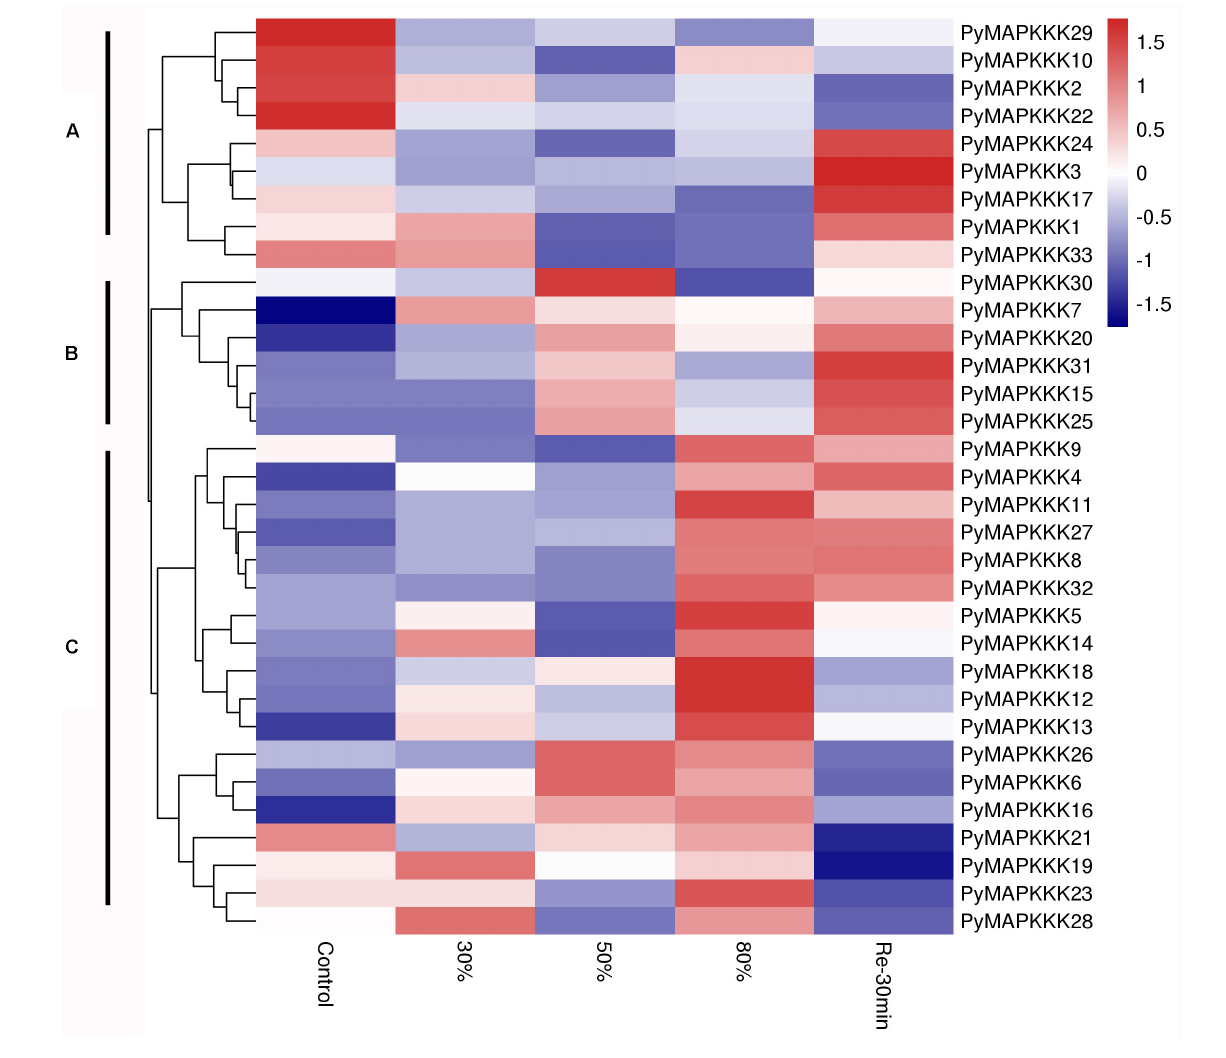
FIGURE 5 | Hierarchical clustering of the expression profiles of all 33 PyMAPKKK genes in different drought stress. Log2-transformed expression values were used to create the heat map. The red or blue color represent the higher or lower relative abundance of each transcript in each sample, compared to the median expression value of that gene in the whole sample set. Genes were clustered (A–C) according to their expression profiles. 30 represents water loss 30%, 50 represents water loss 50%, 80 represents water loss 80%, Re30min represents rehydration 30 min after water loss